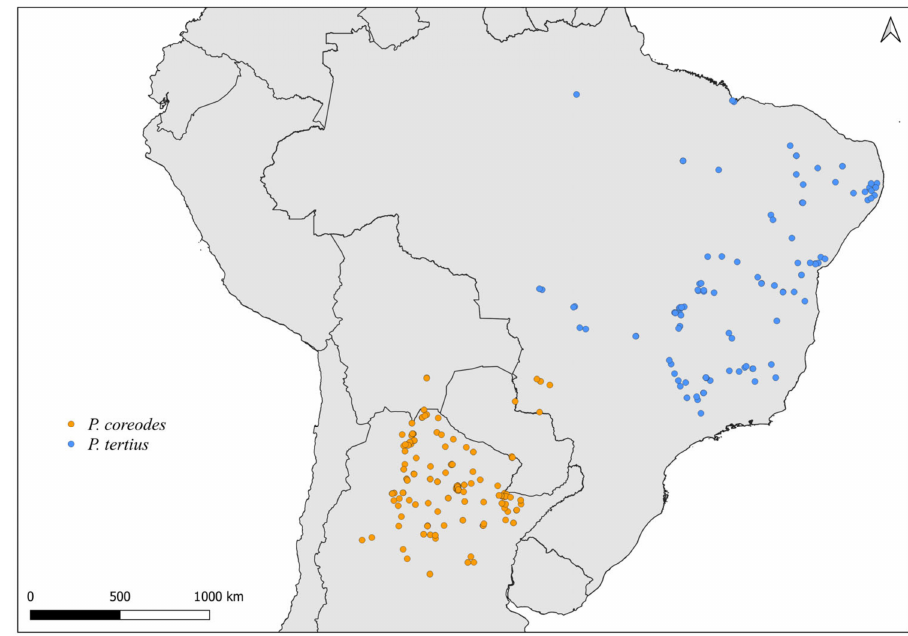
Figure 4. Distribution maps for P. coreodes and P. tertius